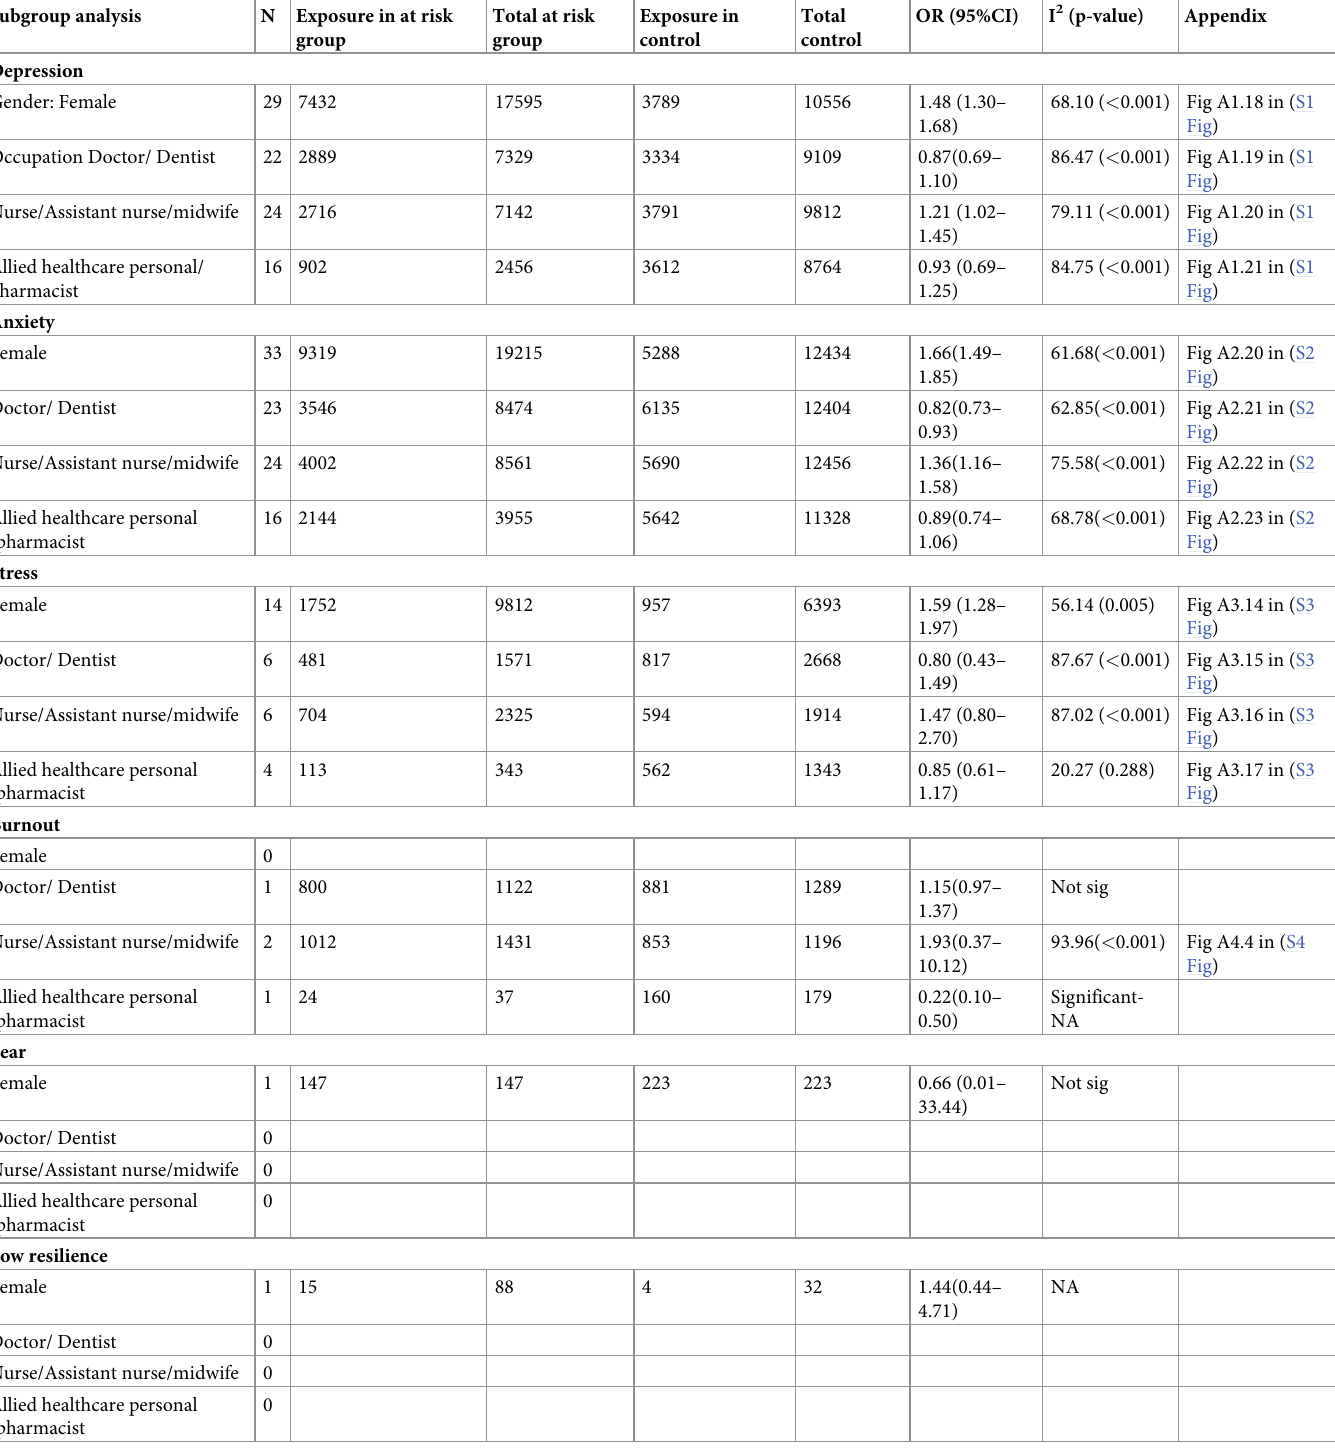
Table 4. Subgroup analysis of odd ratio of psychological distress among HCPs according to gender and